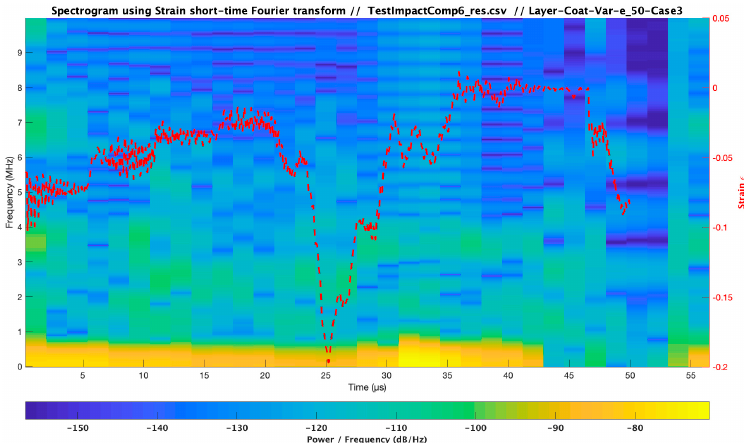
Figure 33. Spectrogram for strain evolution at the middle coating layer, 50% thickness, considering substrate-filler as semi-infinite with variation in droplet diameter. Case 3.